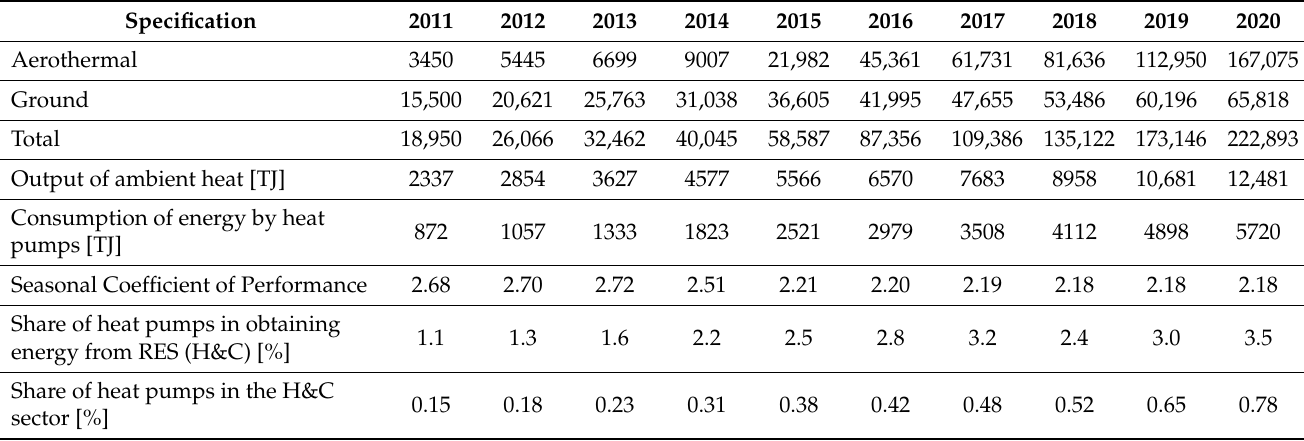
Table 1. Number of operating heat pumps in Poland in